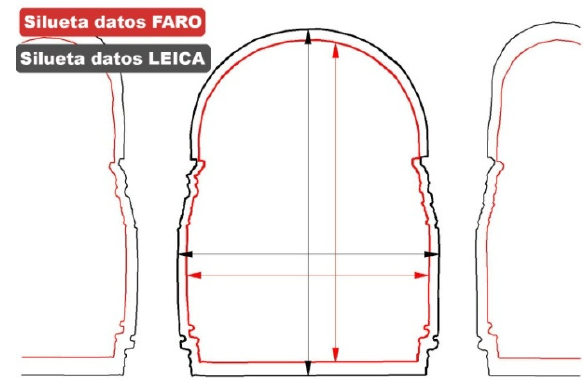
Figure 17. Significant scale differences have been found.